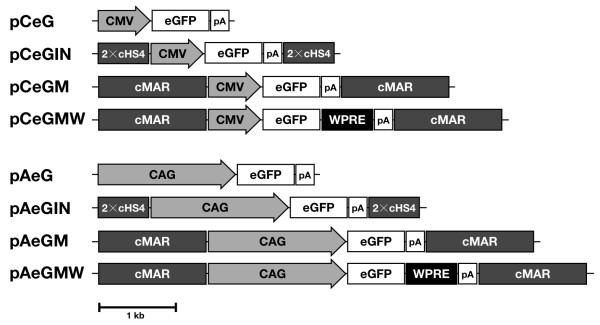
Construction of the vectors containing different cis-regulatory elements. CMV, human cytomegalovirus immediate-early enhancer/promoter; CAG, CMV enhancer + chicken beta-actin promoter + rabbit beta-globin intron; eGFP, enhanced green fluorescent protein; pA, bovine growth hormone polyadenylation signal; cMAR, chicken lysozyme matrix attachment region (BamHI-PvuI fragment); cHS4, the core region of chicken beta-globin insulator (250bp); WPRE, woodchuck hepatitis virus posttranscriptional regulatory element.